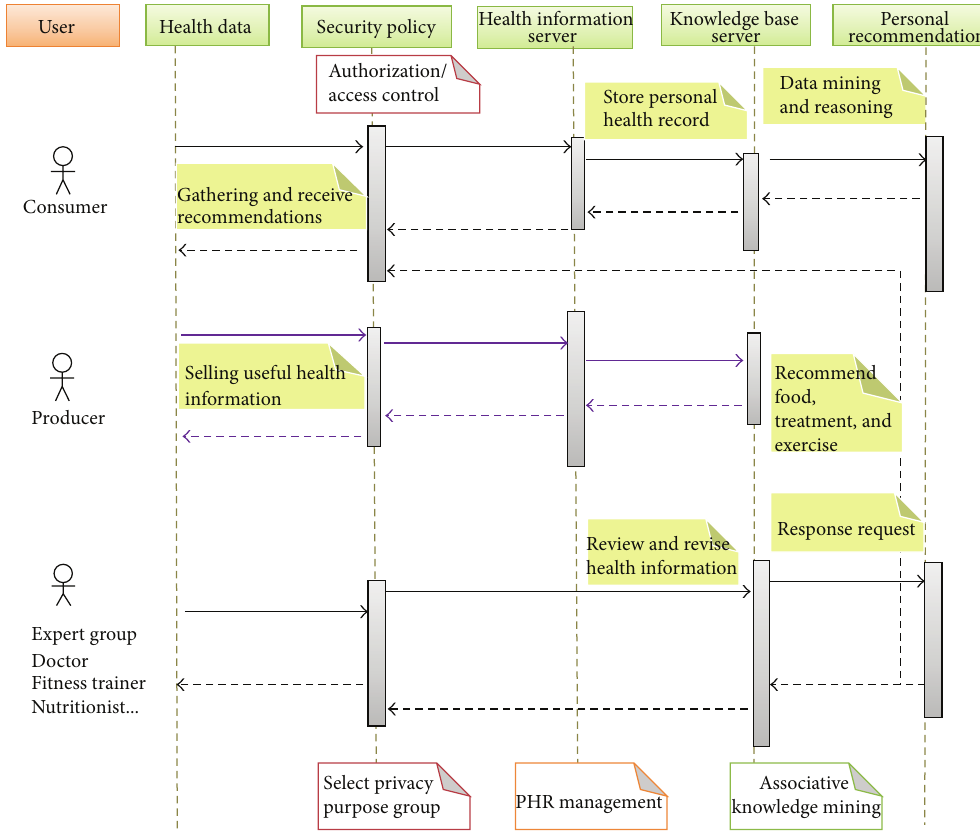
Figure 14: The workflow of